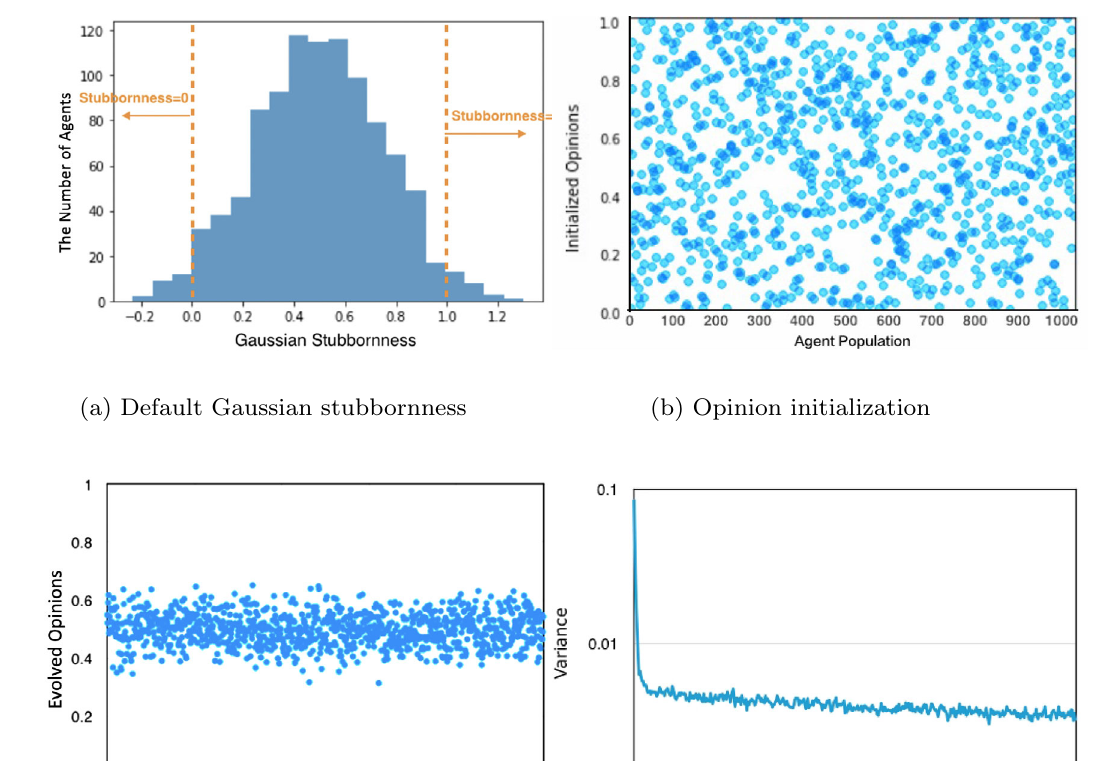
Fig. 2. The opinions of agents are reasonably different